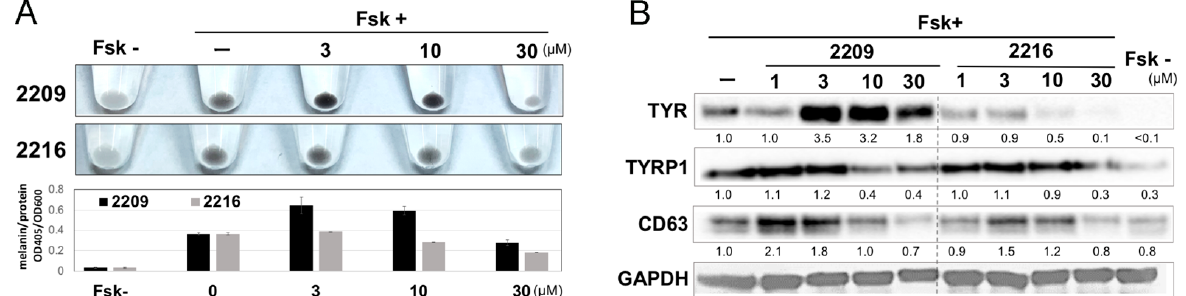
Figure 2 . ( A ) B16F10 cells were treated with 20 μ M Fsk and the indicated concentrations of GIF-2209 or GIF-2216 for 48 h. Cells were recovered in sample tubes and collected by centrifugation for the visual examination, and melanin content was measured after alkaline lysis and normalized to protein content. n = 3. (B ) Western blot analyses. The images are representative of triplicate experiments. The band intensity for TYR, TYRP-1, and CD63 was measured by ChemiDoc XRS and normalized to GAPDH intensity.